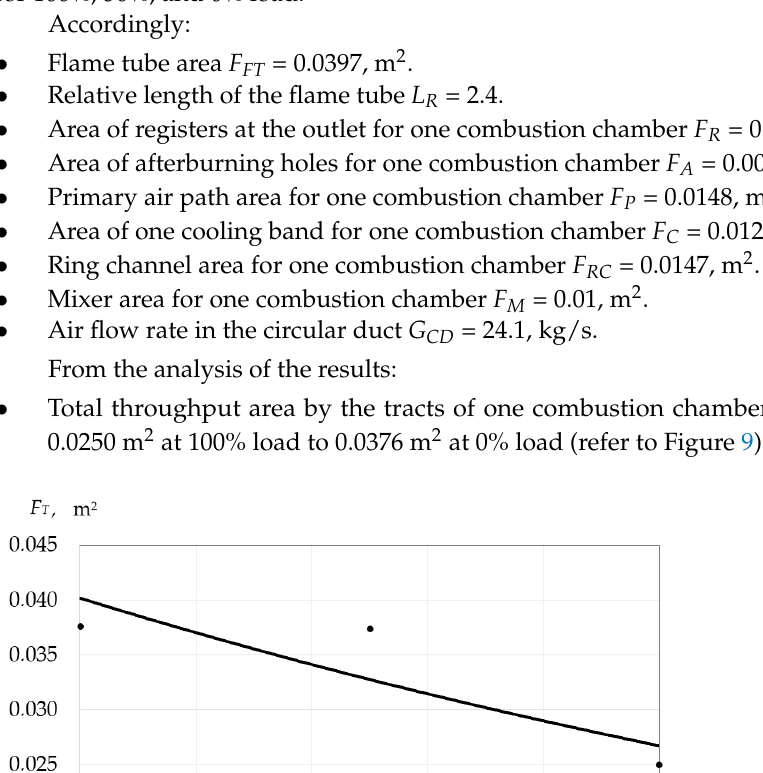
Figure 10. Dependence of combustion chamber forcing on the load value. • Average air velocity along the tracts ω A decreases from 70.1 m/s at 100% load to 42.7 m/s at 0% load (refer to Figure 11).